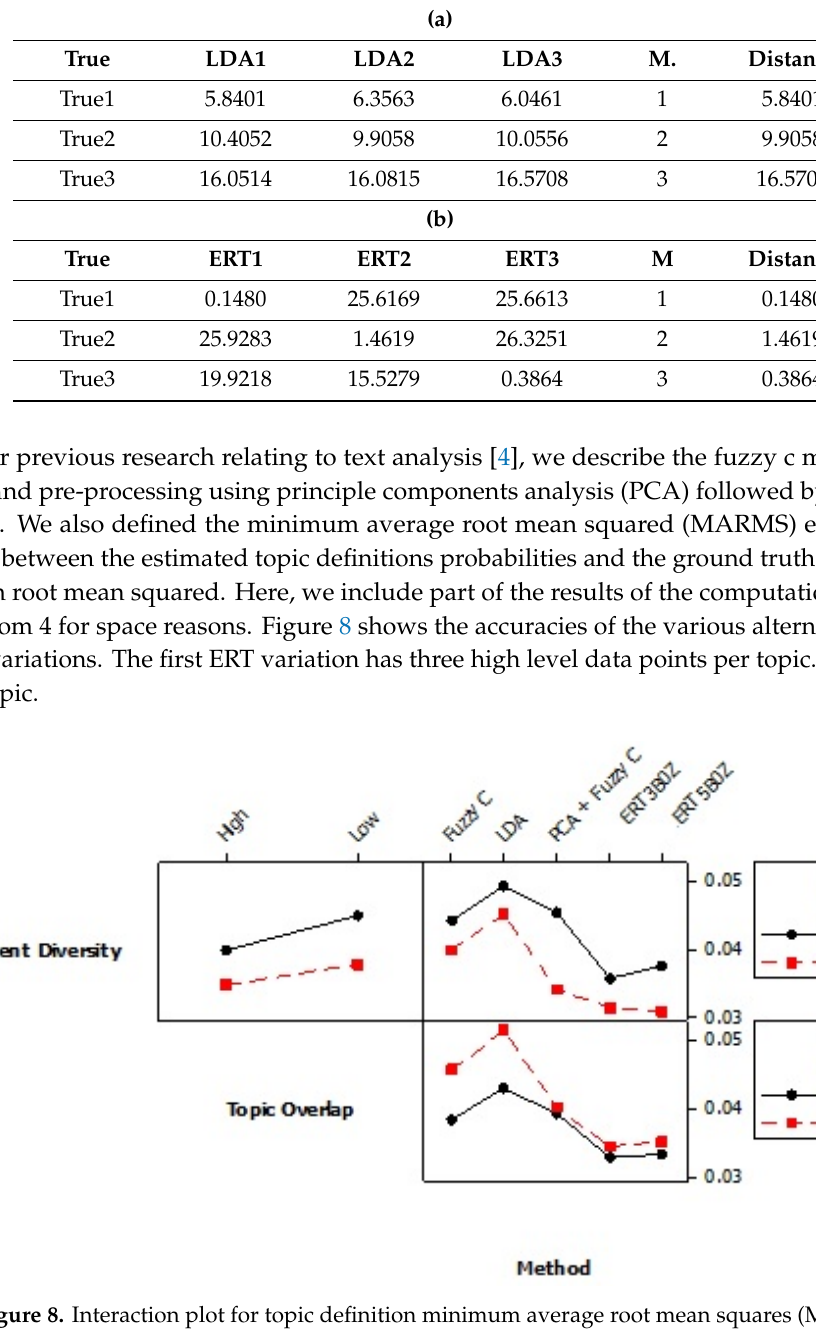
Table 2. Kullback–Leibler (KL) distances from: ( a ) sampling (S) to LDA topics; ( b ) sampling to ERT topics.